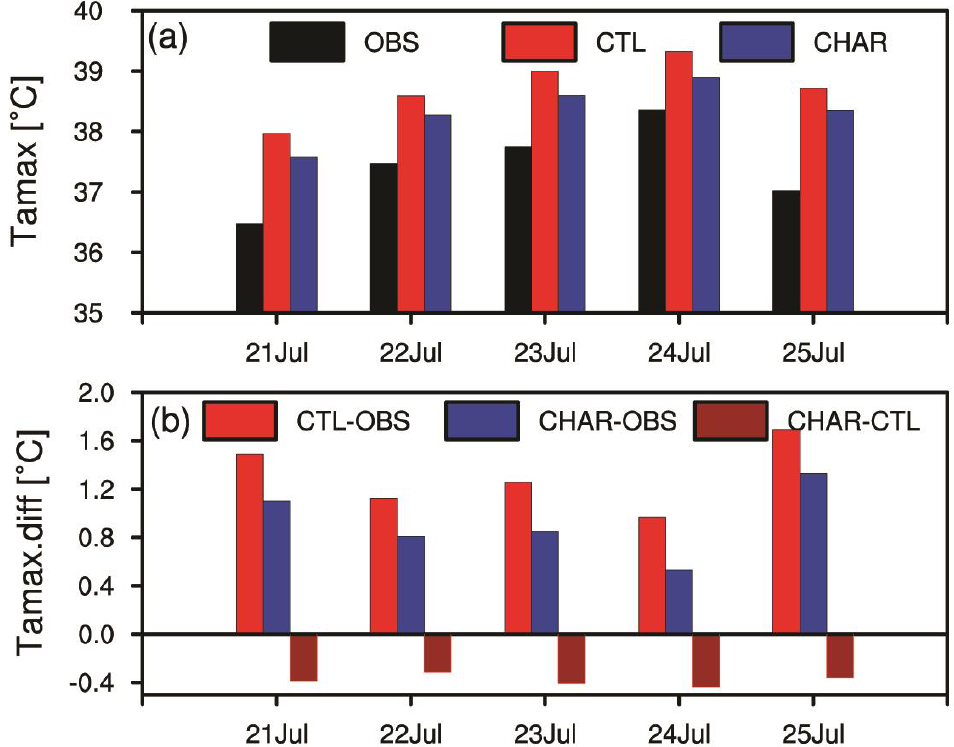
Figure 9. ( a ) Daily variations of area-averaged observed and simulated maximal air temperature, and ( b ) their difference (unit: °C) over the research period in EC.